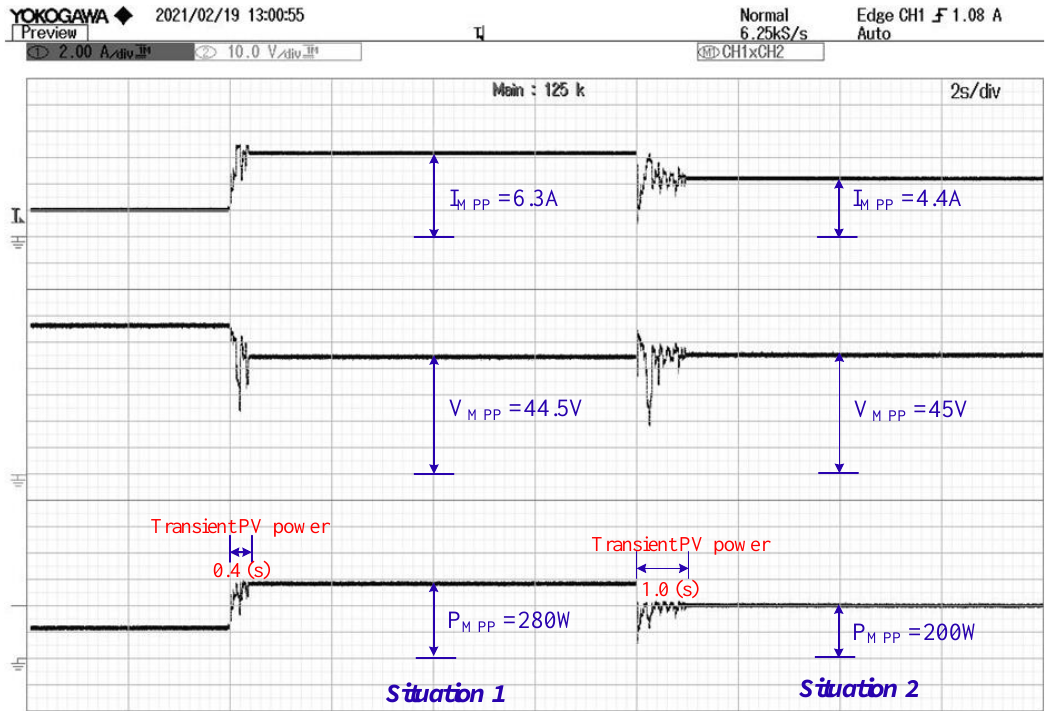
Figure 15. Experimental results of the GWA method (top to bottom: PV current, PV voltage, PV power).